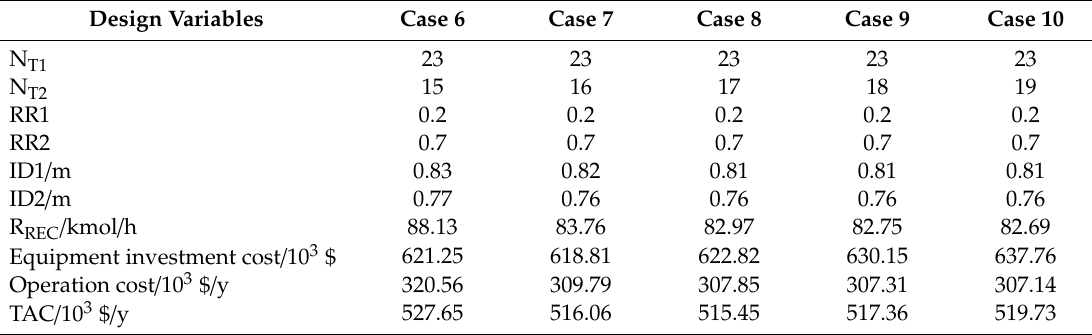
Table 3. Specific results for the tray number of the high pressure column (HPC).